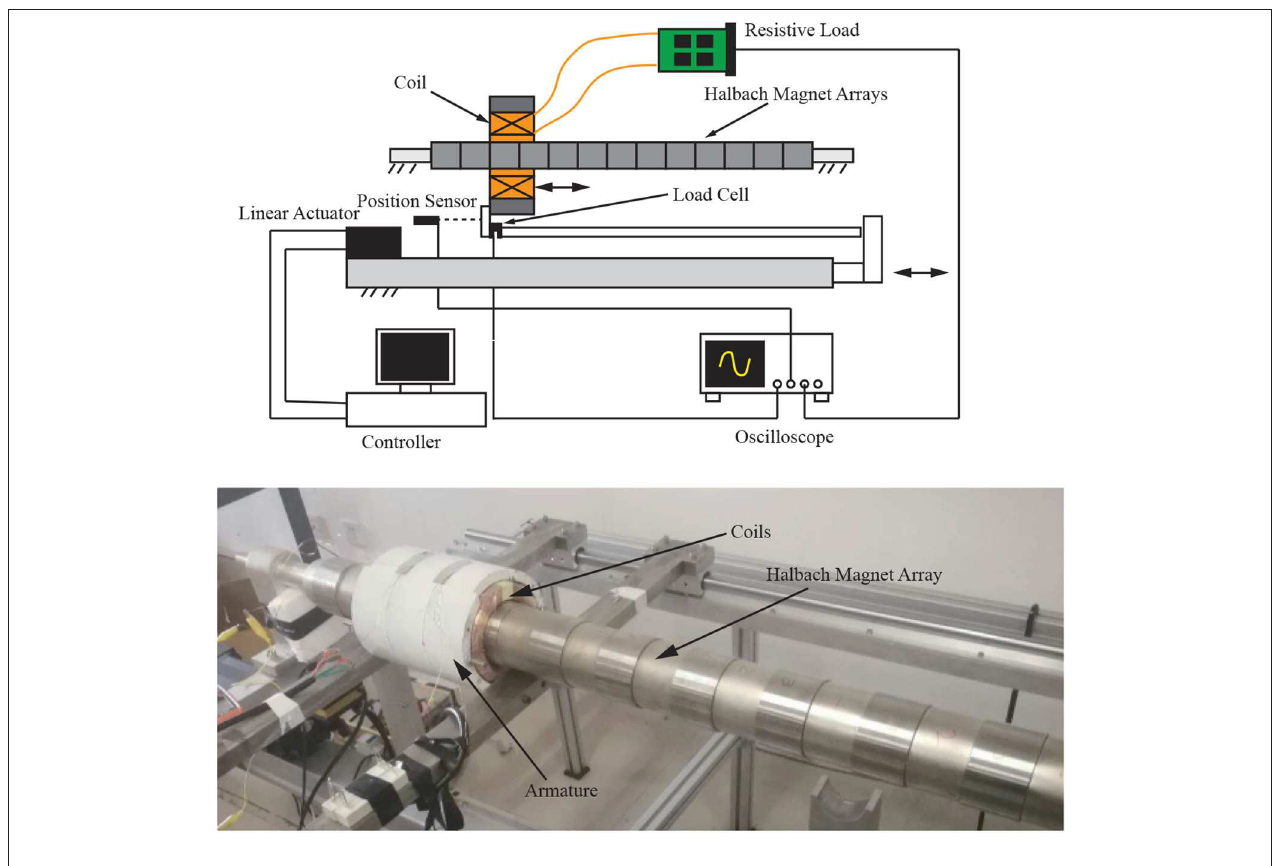
FIGURE 13 | Test-rig for the PTO